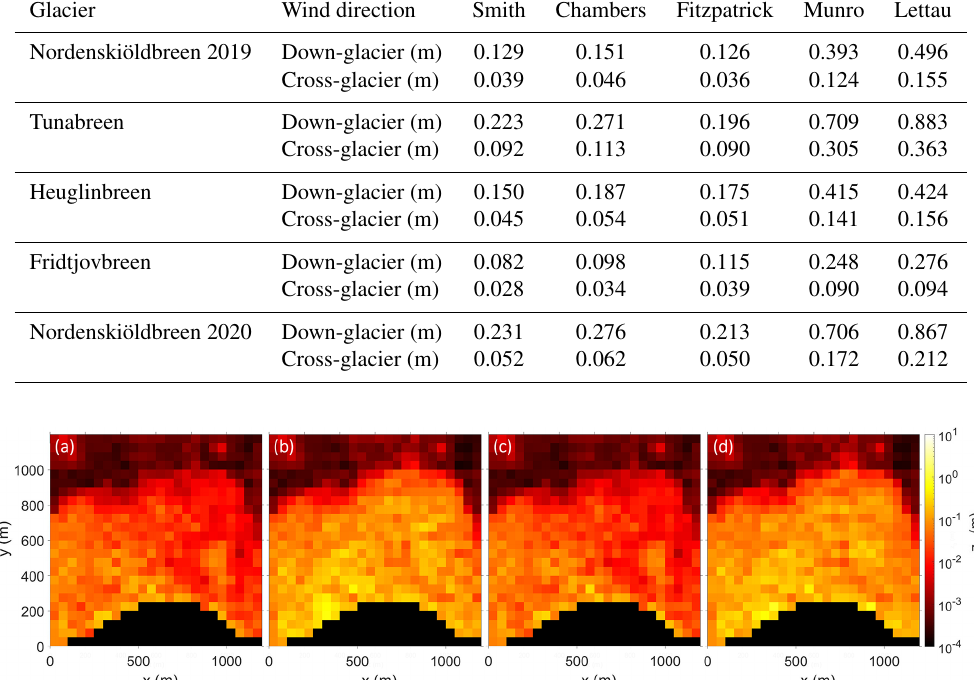
Figure 5. Variability in z 0 values for Fridtjovbreen depending on the wind direction for a sub-grid size of 50m calculated with the Smith model. Winds blowing across the glacier either from the left-to-right (a) or right-to-left (c) produce smaller z 0 values than down-glacier (b) or up-glacier (d) wind systems.